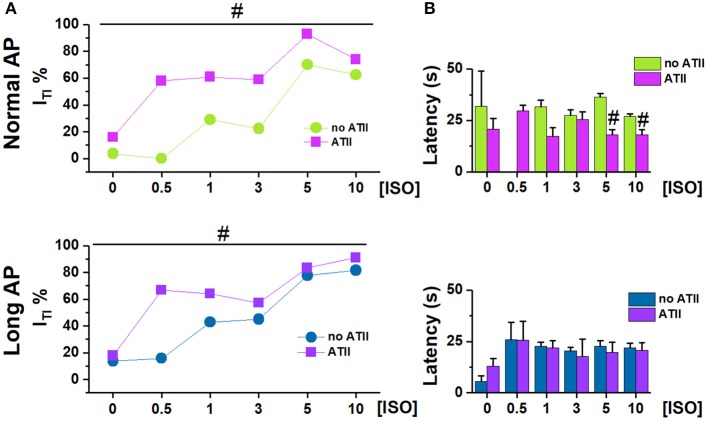
Effect of adding ATII on ITI incidence under Normal AP and Long AP. (A) ITI incidence and (B) latency at different ISO concentrations (nM) in untreated (noATII) and ATII- treated (ATII) CMs. N > 20 for all groups. #p < 0.05 vs. ISO group.